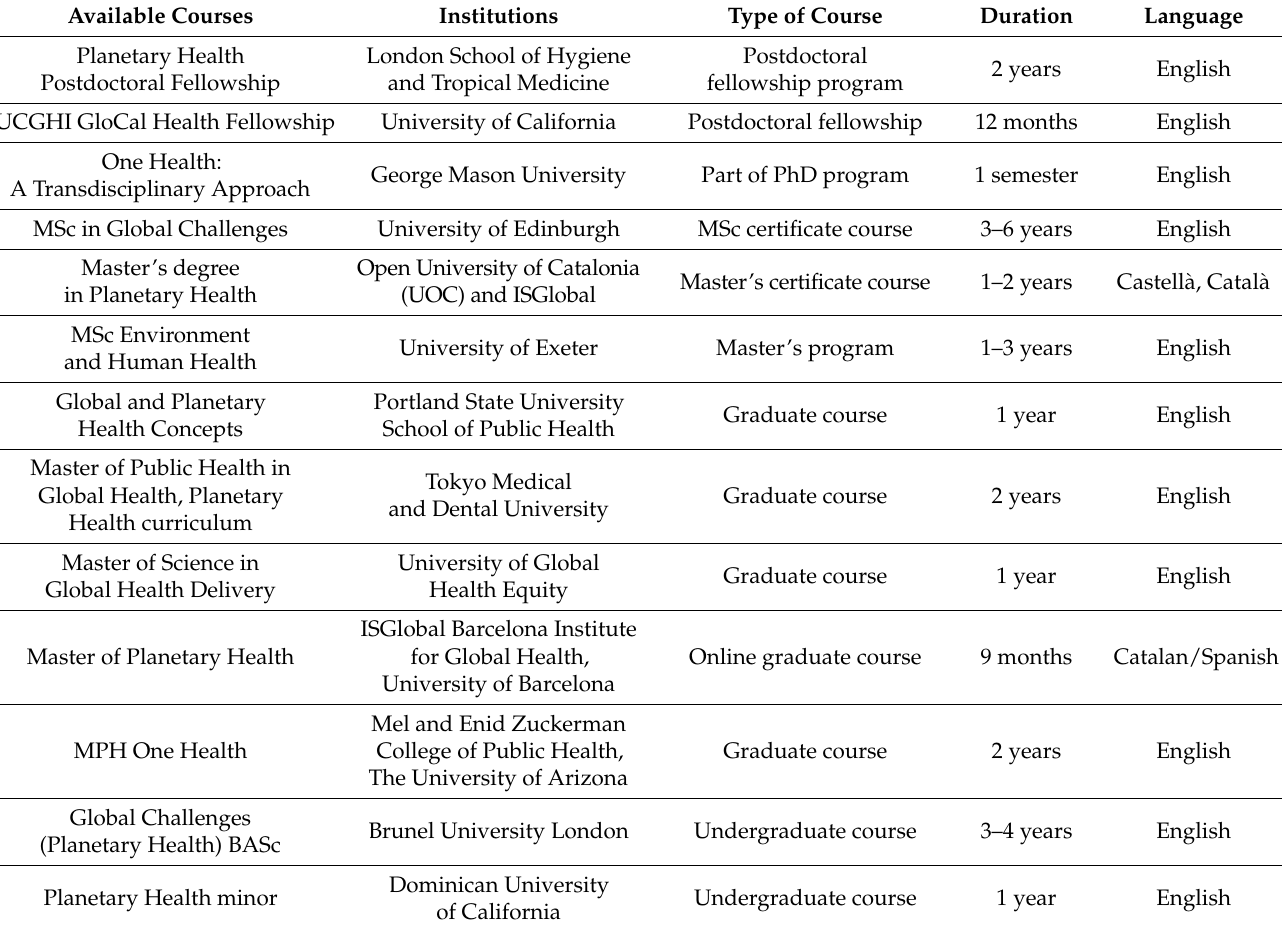
Table 2. Available long courses for planetary health